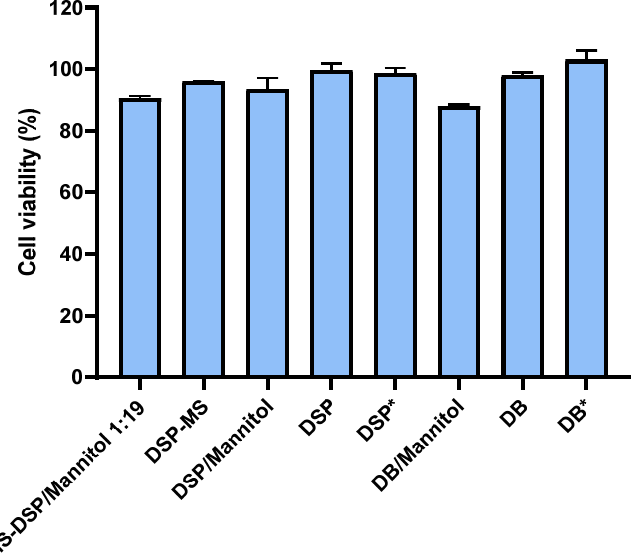
Figure 9. Viability of cells (MTT test) in Calu-3 cell monolayers used in permeability studies of DSP from DSP-MS suspensions and DSP solutions with and without mannitol. Corresponding DB solutions were also included in the study (see Table 3). Concentration of DSP, DB and mannitol (where applicable) in the test samples was equal to 0.9 mg mL − 1 , 0.075 mg mL − 1 and 54.5 mg mL − 1 , respectively. Data are expressed as mean ± SD ( n = 3). DSP * ( p < 0.05); DB * ( p <